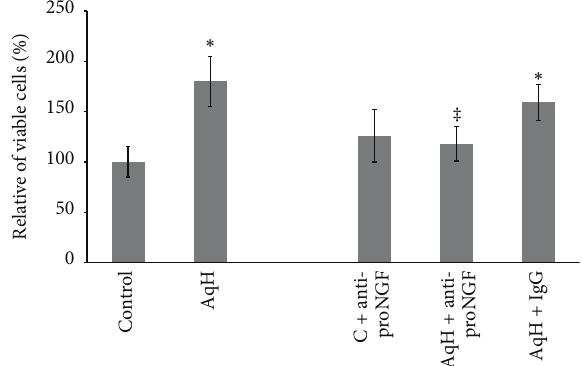
Figure 3: ProNGF and aqueous humor from PDR patients stim- ulated cell proliferation. HRE cells were grown into confluence then trypsinized and plated as described in method section. Cells were switched to serum free medium and treated with aqueous humor samples (10 𝜇 L/mL) in the presence or absence of either anti-proNGF antibody or rabbit IgG (1 𝜇 g/mL) for 24 hours then cells were trypsinized and counted. Statistical analysis showed that aqueous humor from PDR patients stimulated cell proliferation by 1.8-fold compared to the control group. Adding anti-proNGF antibody to aqueous humor samples significantly reduced the relative number of proliferating cells while IgG did not. Addition of anti-proNGF antibody to HRE cells did not affect number of proliferating cells ( ∗,‡ statistically significant compared to control and aqueous humor groups, resp., ( 𝑃 < 0.05 ), 𝑛 of aqueous humor samples = 6, 𝑛 of cell cultures =